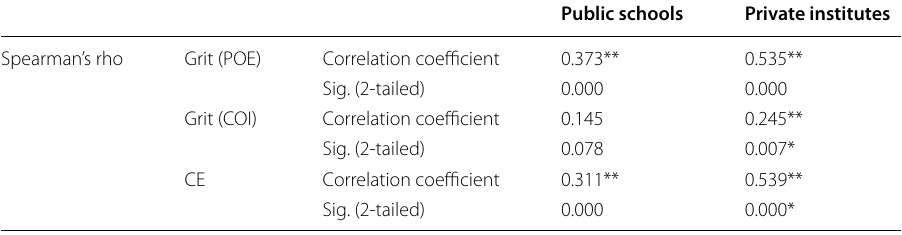
**Correlation is significant at the 0.01 level (2‑tailed) *Correlation is significant at the 0.05 level